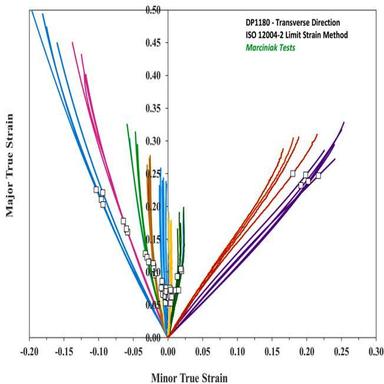
DP1180 limit strains and strain paths until the onset of fracture obtained using Marciniak tests with a 101.6 mm diameter punch and carrier blank hole diameter of 32 mm. The symbols show the limit strains obtained by ISO 12004-2 method.